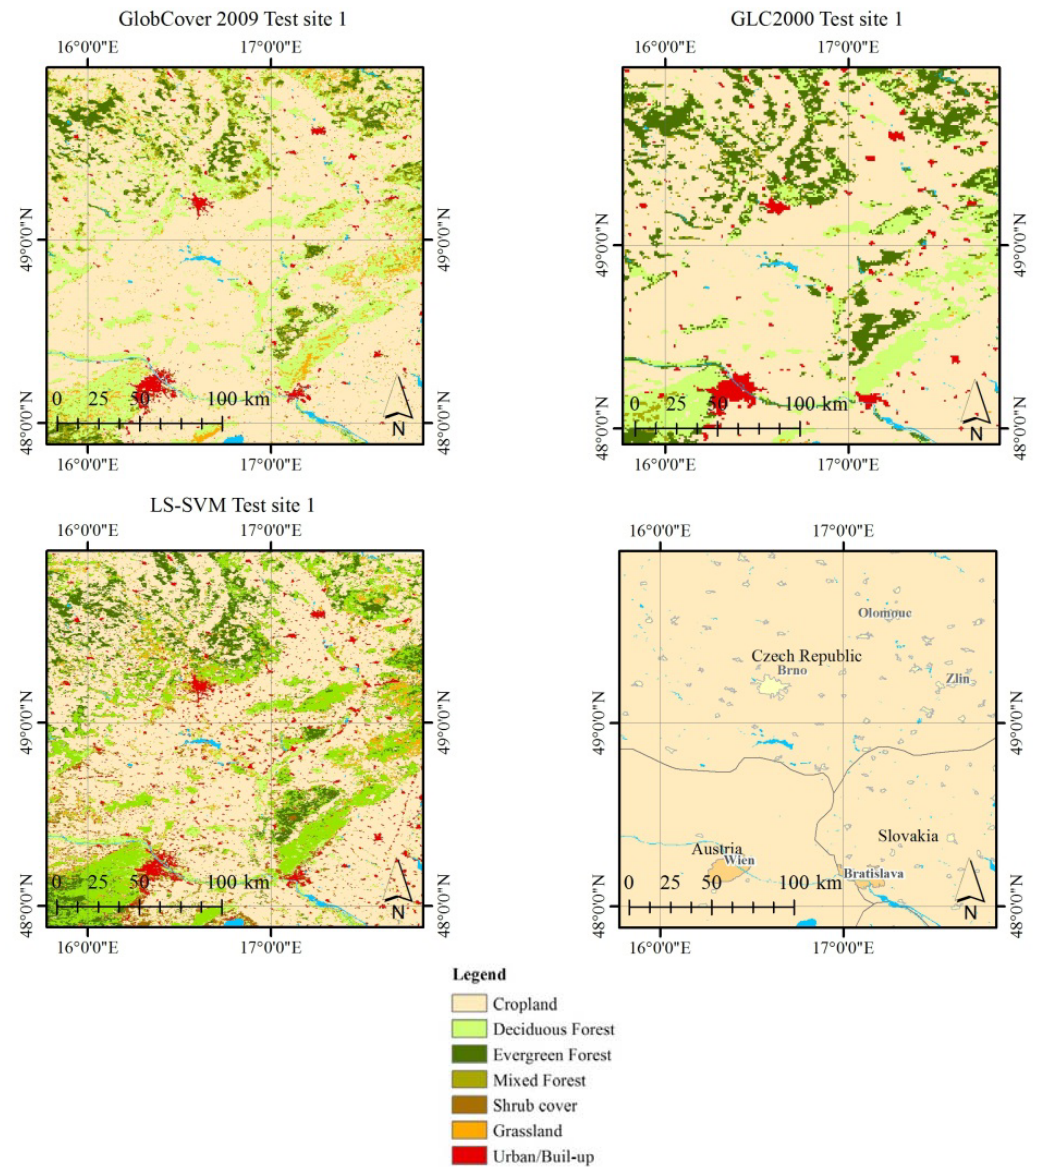
Figure 9. Examples of GlobCover, GLC2000 and LS-SVM maps for a small region between the cities of Vienna (Austria), Bratislava (Slovakia) and Brno (Czech